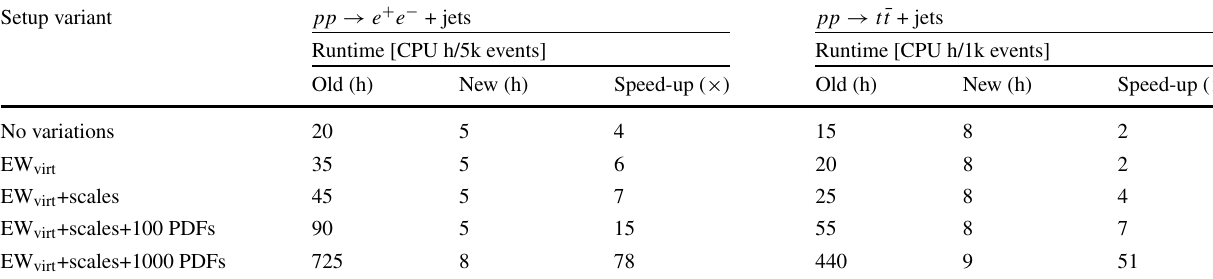
ing with the number of additional variation weights is benchmarked through a few representative setup configurations